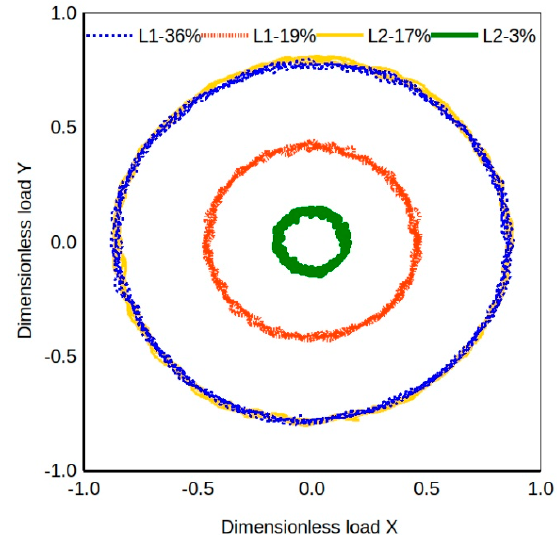
Figure 4. Horizontal and vertical dynamic load plot for the four-pad tilting pad journal bearings (TPJB). Red and blue lines for the lower static load L1 and increasing dynamic/static load ratio, and green and yellow for the higher static load L2 and increasing dynamic/static load ratio.